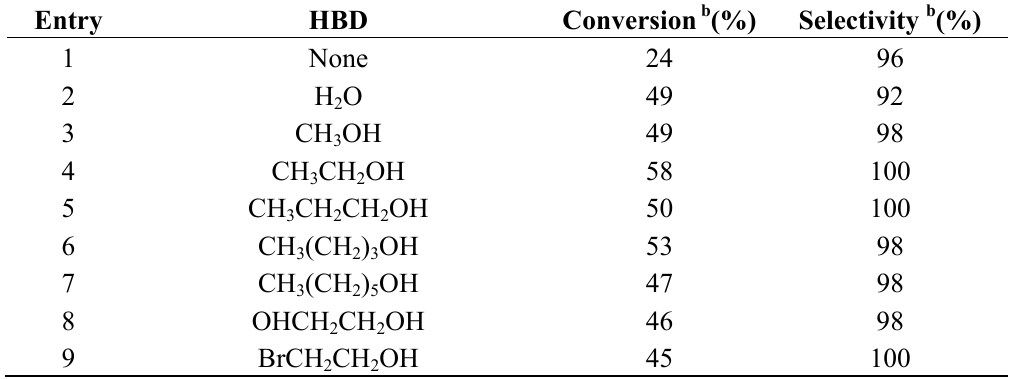
N][Br] with different HBDs a 4